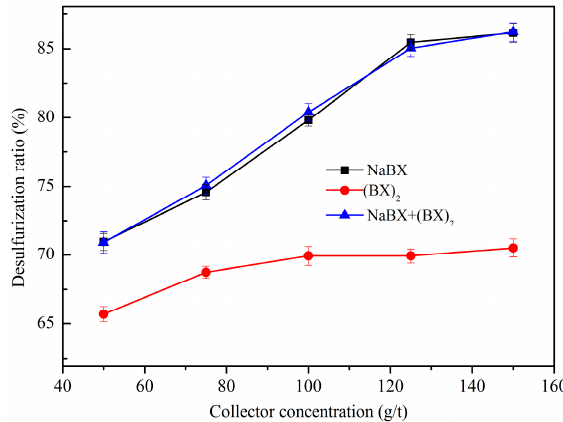
Figure 4. Desulfurization ratio of flotation performance with individual collector NaBX, (BX) 2 and mixed collector (m (cid:2898)(cid:2911)(cid:2886)(cid:2908) :m ((cid:2886)(cid:2908)) (cid:3118) = 3:2) as a function of collector concentration (NaSiF 6 500 g/t, pine oil 46 g/t, pH = 6).